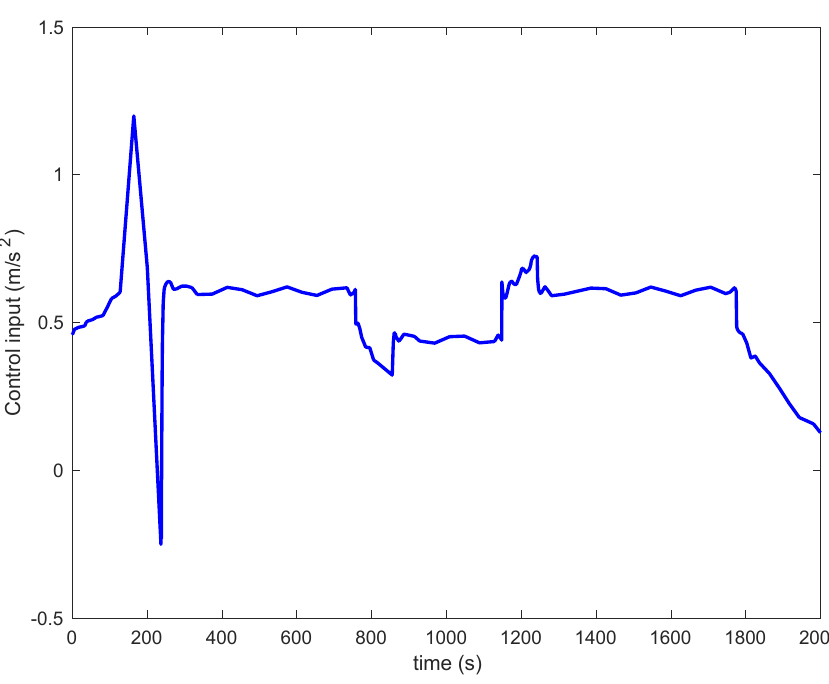
Figure 8. Control Figure 8. Control input.